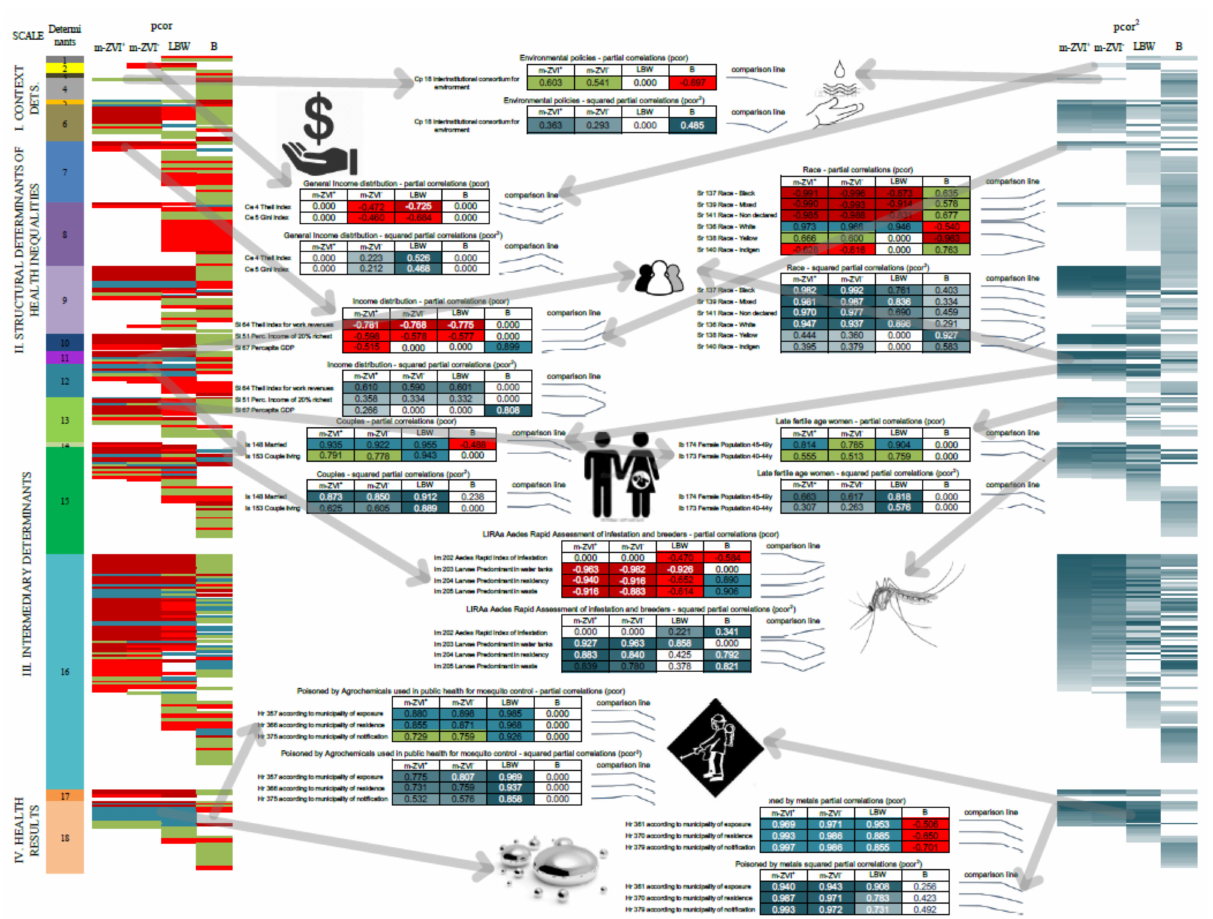
Figure 5. Summary of the Analysis. The right and left margins show case and control subnetworks comparative fingerprints of pcor and pcor 2 values by ordered color gradients. These fingerprints are analogous to single columns of heat maps. The descending order of pcor 2 inside each determinant of the m-ZIKV + subnetwork defines the order of color gradients for all other control networks. Between fingerprints at margins, we extracted (according to arrows) the values that detailed each compared pcor and pcor 2 of subnetworks. From top to bottom, environmental policies common to both types of microcephaly. Next Inward, a table shows differences between macroeconomic indicators between both types of microcephaly followed by income municipal unequal distribution, and inversely proportional relationship of both types of microcephaly with higher income populations. Differential involvement of white, couples and late fertile age women populations showed potential biological vulnerabilities. The relevant relationships of ZIKV-related microcephaly with mosquito breeding but not with mosquito populations other than non-specific relationships with agrochemicals used in public health are also present and are even higher with LBW. This would tend to dampen the effect and the effectiveness of this intervention. The last relationship and higher values for both types of microcephaly is an emergent factor to explain non-ZIKV-related microcephaly which may be an indirect moderator of ZIKV-related